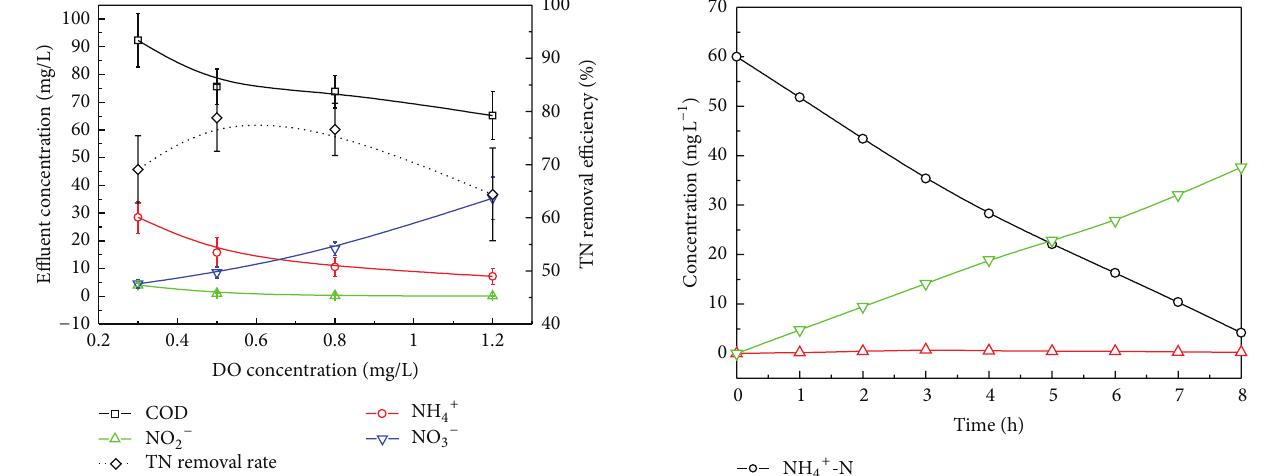
and N in batch test are 420 and 60 mg L −1 , respectively.